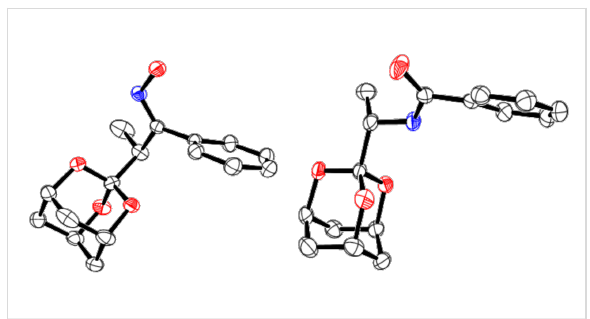
Figure 1: Crystallographic ORTEP diagram at 30% ellipsoidal proba- bility of oxime 3a (left) and amide 5a (right, Scheme 1, Table 1) [18].